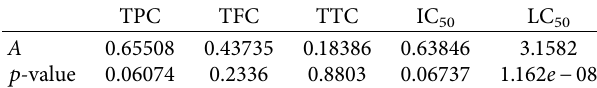
Table 8: Anderson-Darling test for normality.